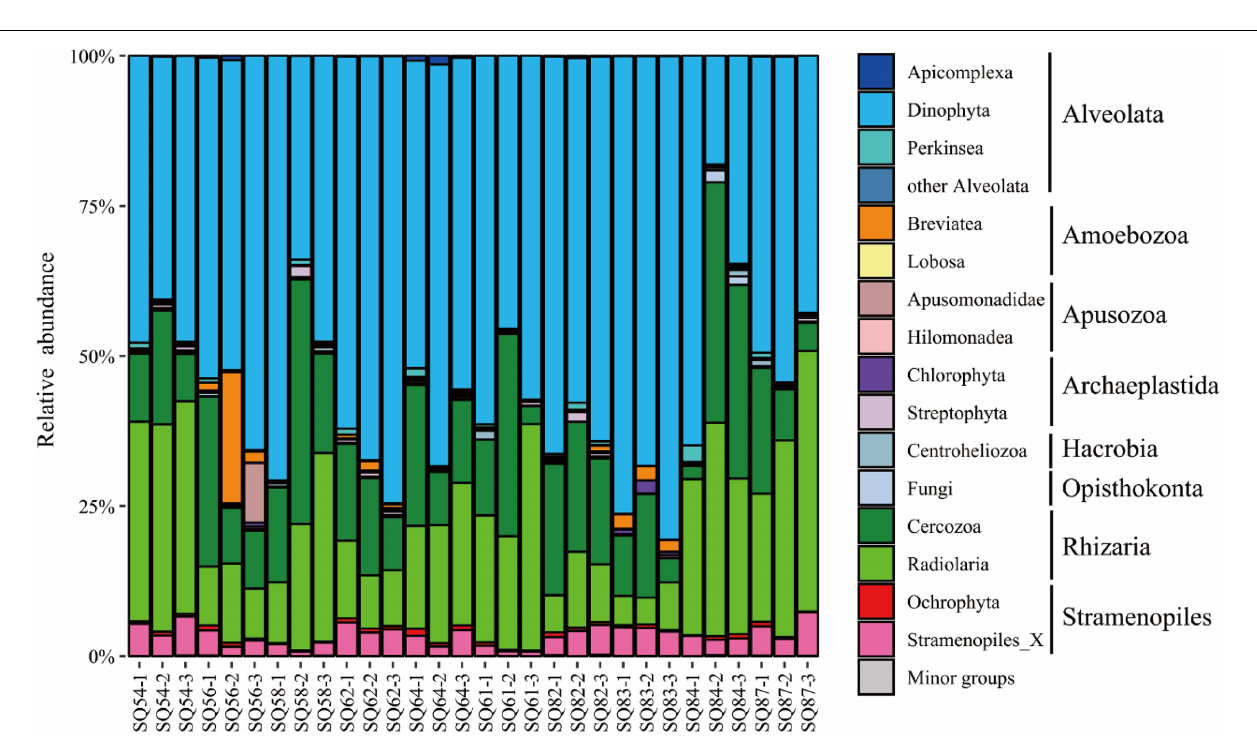
FIGURE 3 | Community structure of the microbial eukaryotes (excluding metazoa) in the sediment samples of the northern South China Sea at the super-group level. The numbers 1, 2, and 3 represent the 0–2, 2–4, and 4–6 cm sediment layers,